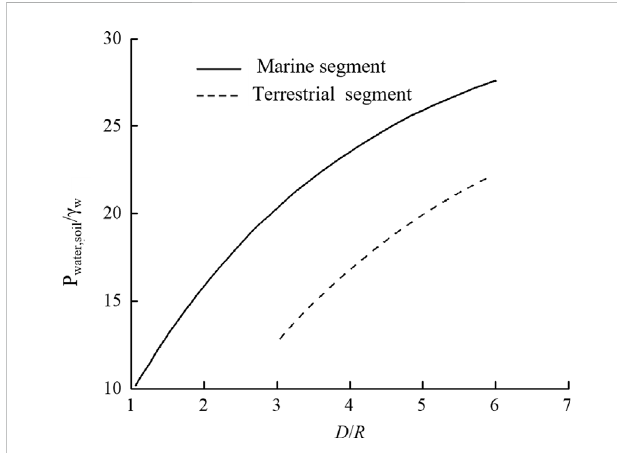
FIGURE 5 The in fl uence of D/R on the water and earth pressure on the top of the tunnel.